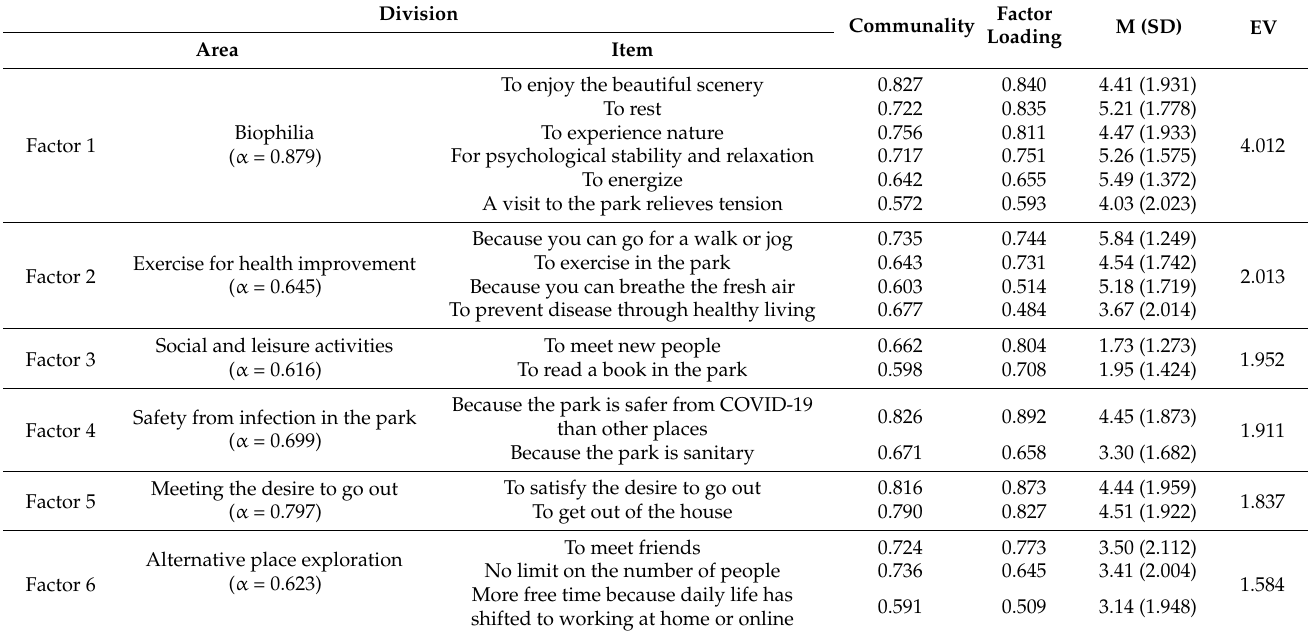
Table 6. Principal Component Analysis of Motivation to Visit Neighborhood Parks.